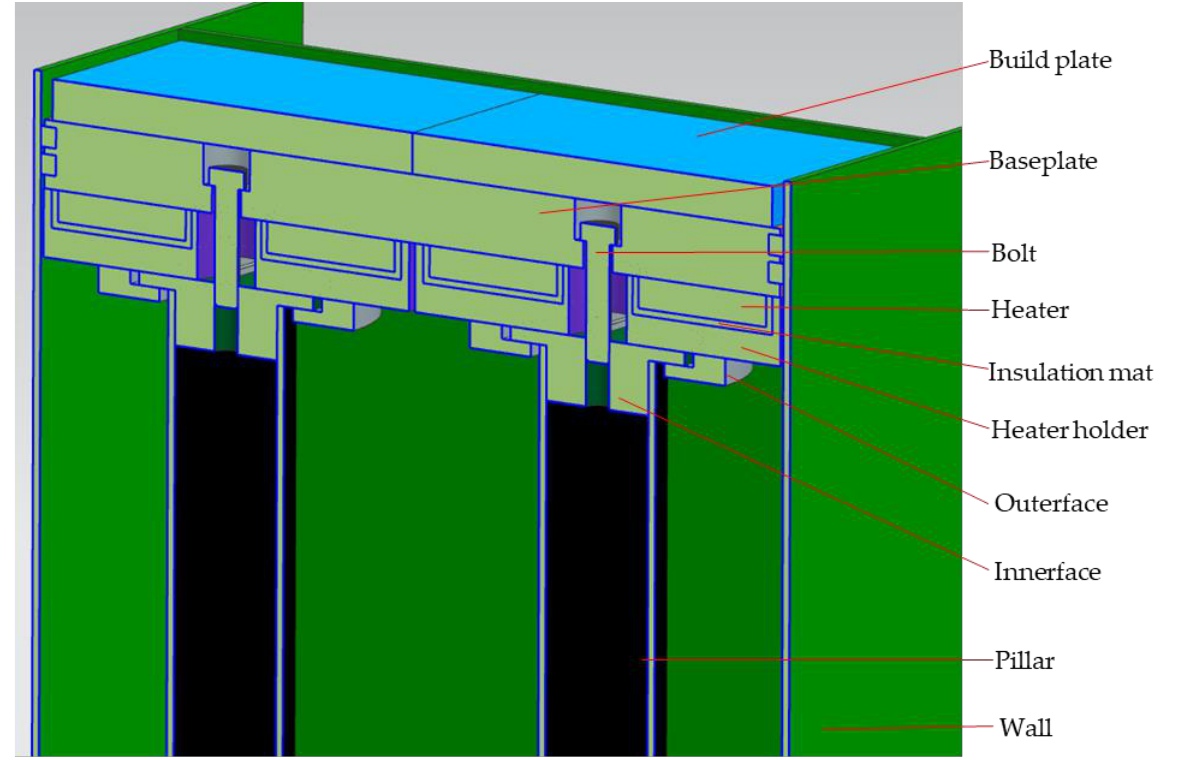
Figure 2. Current powder pool with preheating system.